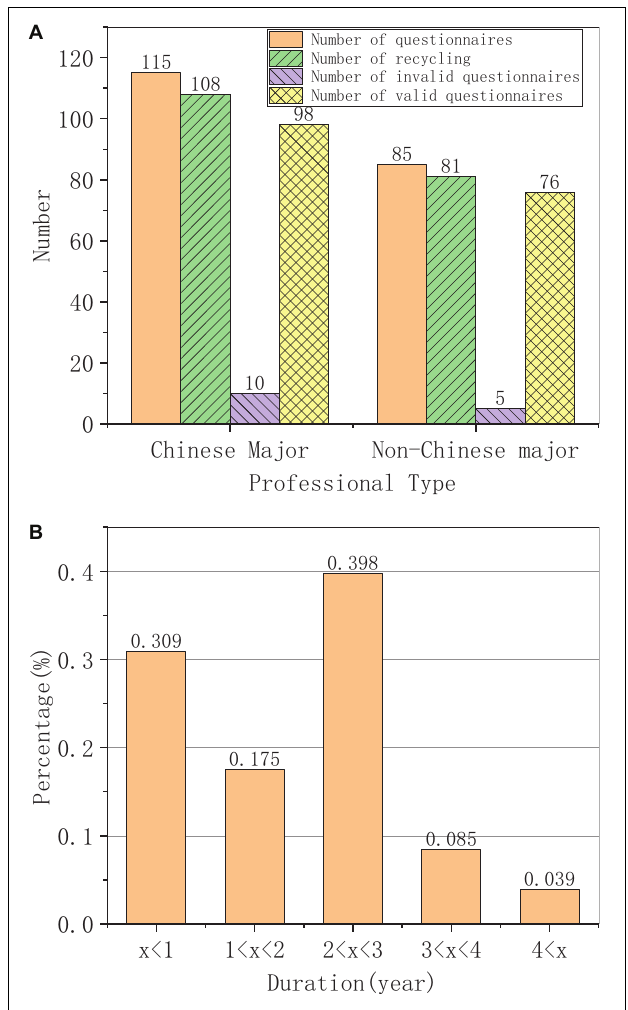
FIGURE 2 | Professional type and Chinese learning duration of foreign students. (A) Professional distribution. (B) Chinese learning duration.